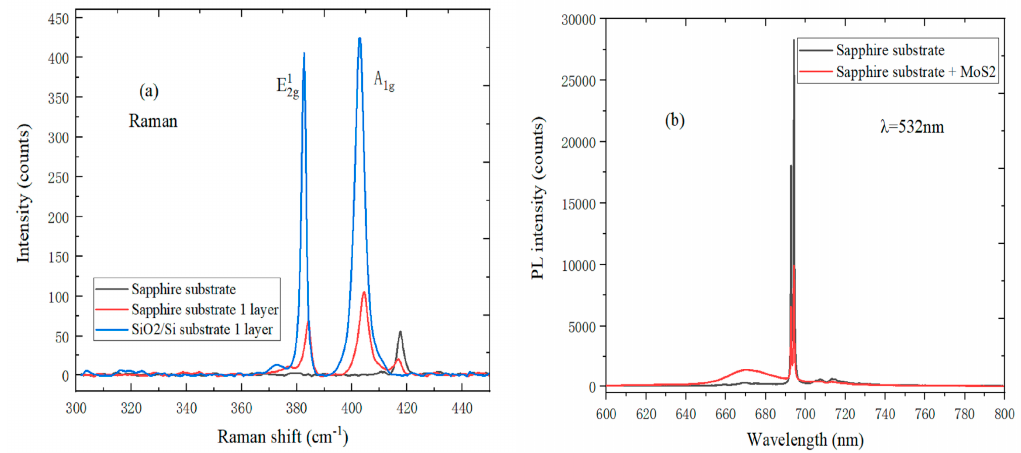
Figure 2. ( a ) Raman spectrum of monolayer MoS 2 on SiO 2 /Si and sapphire substrates; ( b ) PL spectrum of MoS 2 +sapphire and sapphire substrate at the 532 nm laser wavelength.